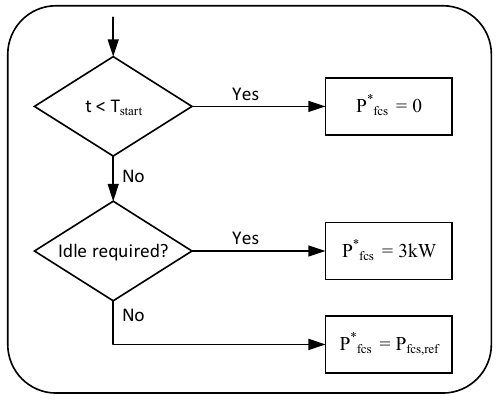
Figure 12. Predictive EMS [28].